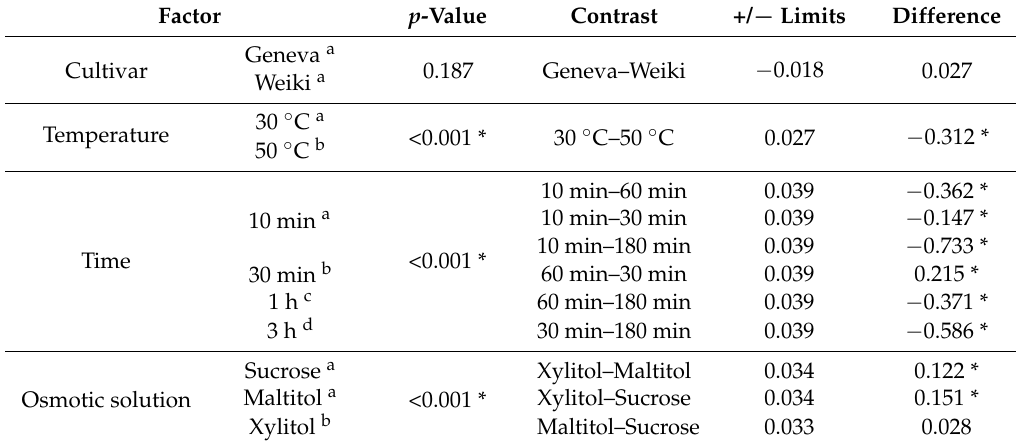
Table 4. The influence of osmotic pre-treatment in different solutions, and time on WL (g/g i.d.m.). Factor p -Value Contrast +/ − Limits Difference Geneva a 0.187 Geneva–Weiki − 0.018 0.027 Cultivar Weiki a 30 ◦ C a Temperature <0.001 * 30 ◦ C–50 ◦ C 0.027 − 0.312 * 50 ◦ C b 10 min–60 min 0.039 − 0.362 * 10 min–30 min 0.039 − 0.147 * 10 min a 10 min–180 min 0.039 − 0.733 * Time <0.001 * 30 min b 60 min–30 min 0.039 0.215 * 1 h c 60 min–180 min 0.039 − 0.371 * 3 h d 30 min–180 min 0.039 − 0.586 * Sucrose a Xylitol–Maltitol 0.034 0.122 * Maltitol a Xylitol–Sucrose 0.034 0.151 * <0.001 * Osmotic solution Xylitol b Maltitol–Sucrose 0.033